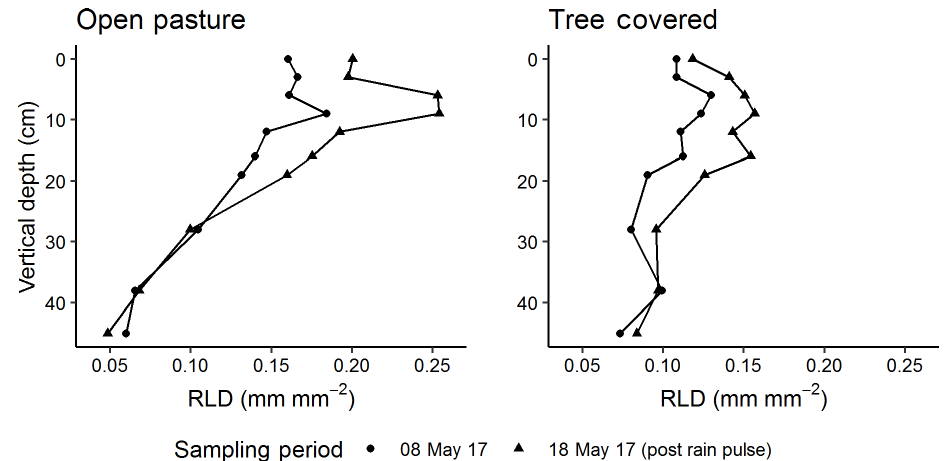
Figure 7. Control treatment root length density (RLD) response to rain pulse in May 2017. RLD throughout the soil profile ( P < 0 . 001 for both microhabitats) indicating short-term proliferation of root growth.